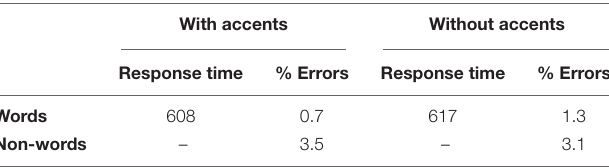
TABLE 2 | Mean lexical decision times (in ms) and error rates (in percentages) for words and non-words with vs. without accent marks in Experiment 2. With